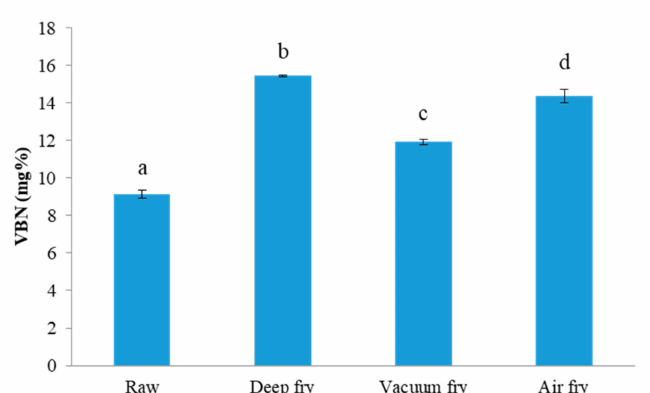
Figure 3. Volatile basic nitrogen (VBN) of chub mackerel ( Scomber japonicus ) in different frying methods. Data are presented as mean ± SD. Different superscript letters (a–d) show significantly different values according to Duncan’s test ( p < 0.05).